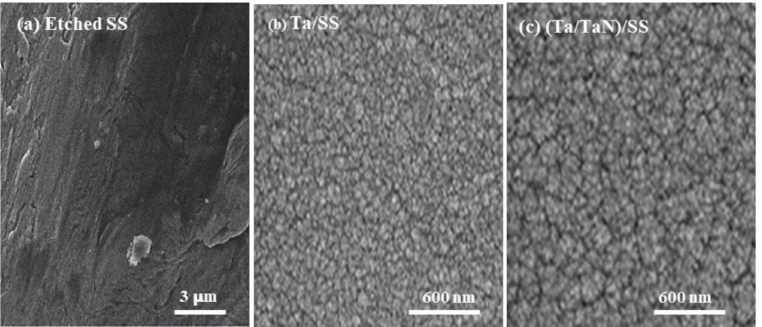
Figure 5. SEM images of substrates: ( a ) etched SS; ( b ) Ta/ SS [26], and ( c ) (Ta/TaN)/ SS [26]. Reprinted with permission from [26], 2017 Elsevier.